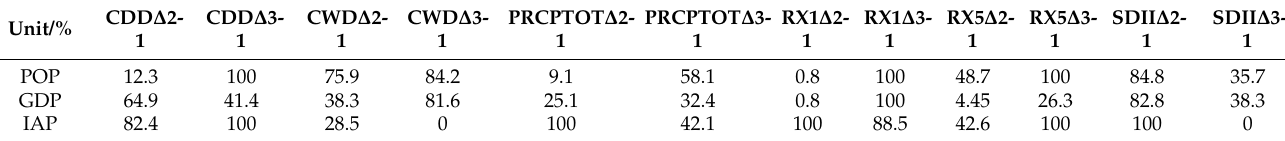
Table 2. The effects of urbanization on extreme precipitation in three-level stations by different classification references. CDD ∆ 2- Unit/%